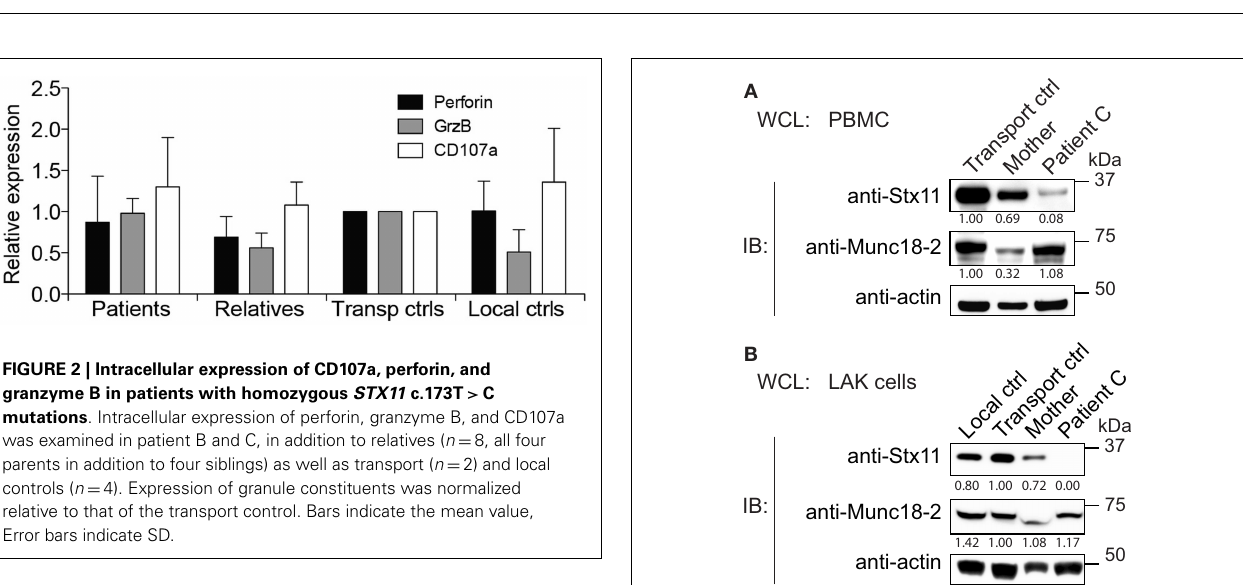
FIGURE 1 | Defective NK cell degranulation in patients with homozygous STX11 c.173T > C mutations . (A–D) PBMC were isolated from three patients with homozygous STX11 c.173T > C, p.L58P mutations, relatives ( n = 10, all six parents in addition to four siblings) as well as transport ( n = 3) and local controls ( n = 5). PBMC (A) freshly isolated or (C) stimulated with IL-2 overnight were mixed with 51 Cr labeled K562 target cells. After 4h, 51 Cr-release was quantified in supernatants and specific lysis was calculated.